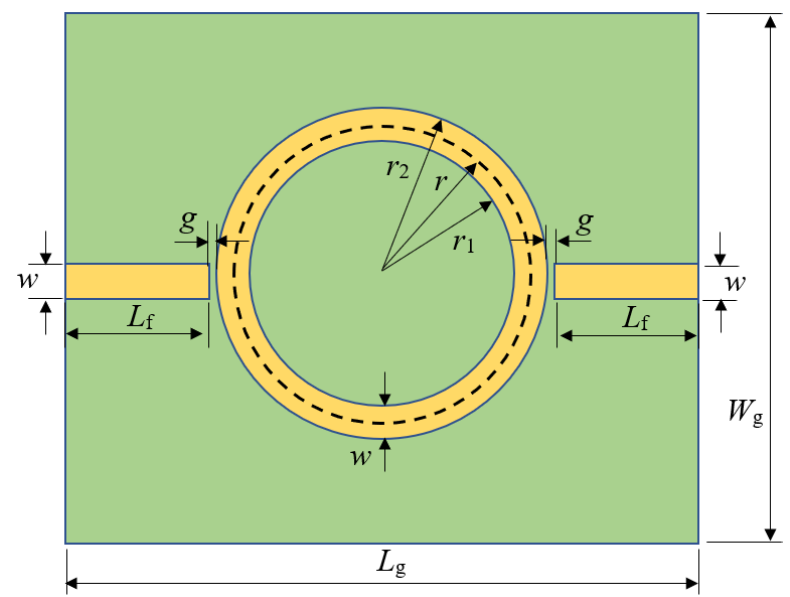
Figure 1. The layout of the microstrip ring resonator (MRR) circuit for characterization of an unknown material